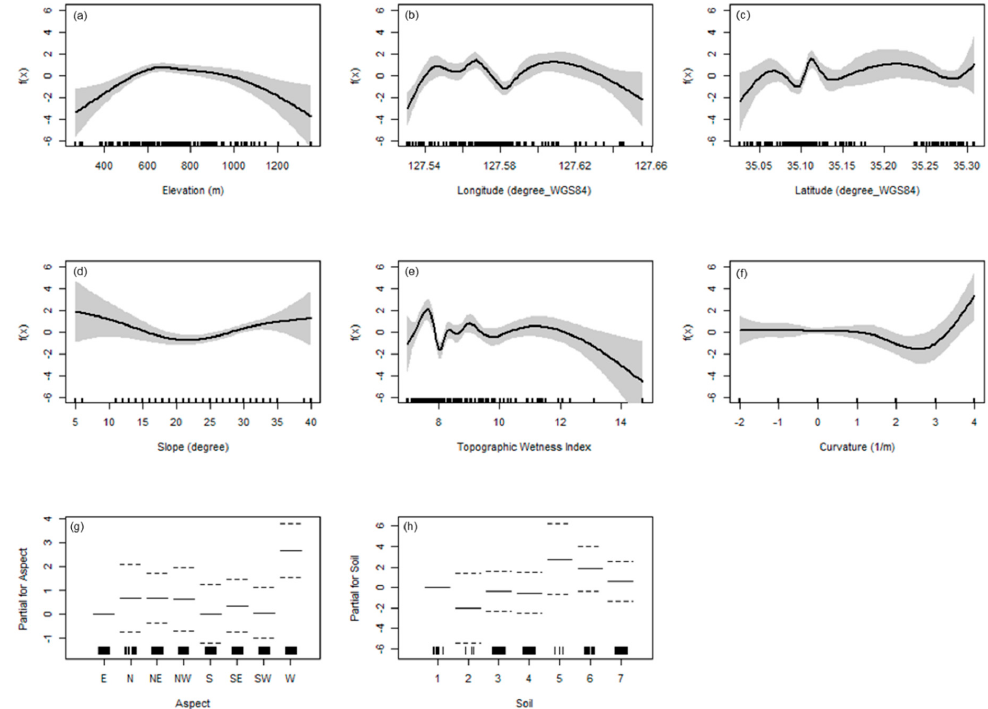
Figure 6. Generalized additive models for species diversity distributions along topographical environment variables (( a ) elevation, ( b ) longitude, ( c ) latitude, ( d ) slope, ( e ) topographic wetness index, ( f ) curvature, ( g ) aspect, and (h) soil). Marks along the x-axis represent individual sample points. The function of species diversity (i.e., f(x)) is expressed in mean deviation form. Grey shading represents 95% confidence intervals. Continuous lines represent smoothing curves. The longitude and latitude are based on the world geodetic reference coordinate system (WGS84). The soil type is represented by 1 (No data), 2 (Clay), 3 (Clay loam), 4 (Loam), 5 (Rock), 6 (Sandy), and 7 (Sandy loam). Forests 2020 , 11 , x FOR PEER REVIEW Among climate variables, annual mean minimum and maximum temperatures ( p < 0.0001 and